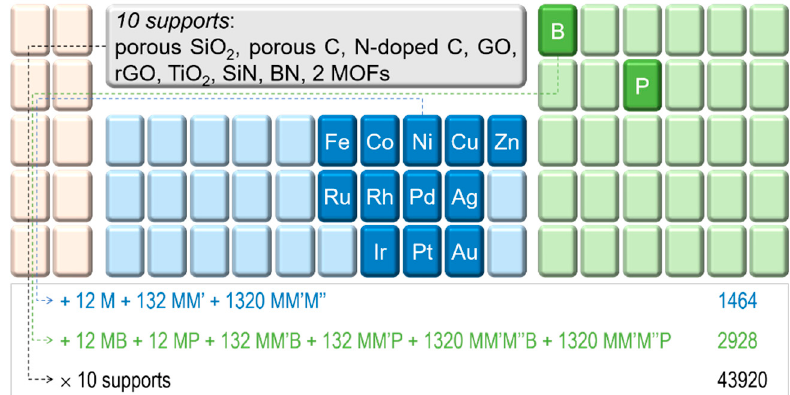
Figure 4. More than 40,000 potential heterogeneous metal-based catalysts, based on the combinations of 10 metals (mono-, bi- and tri-metallic systems, represented by M, MM’ and MM’M’’ respectively), the addition of an element like boron ( B ) or phosphorus ( P ) and supporting onto ten different supports.